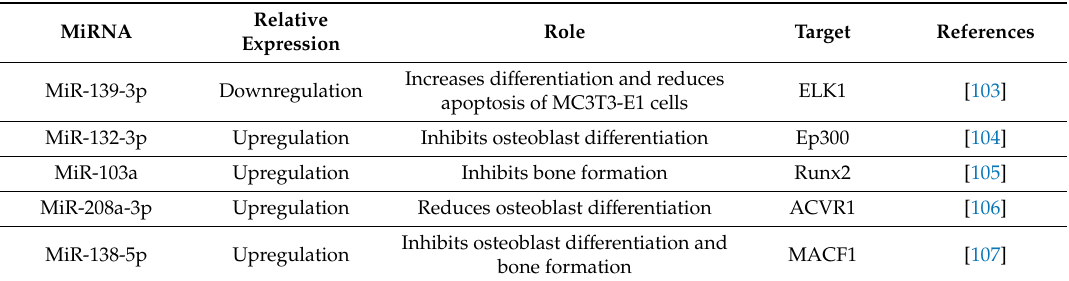
Table 7. MiRNAs involved in osteoblast regulation under